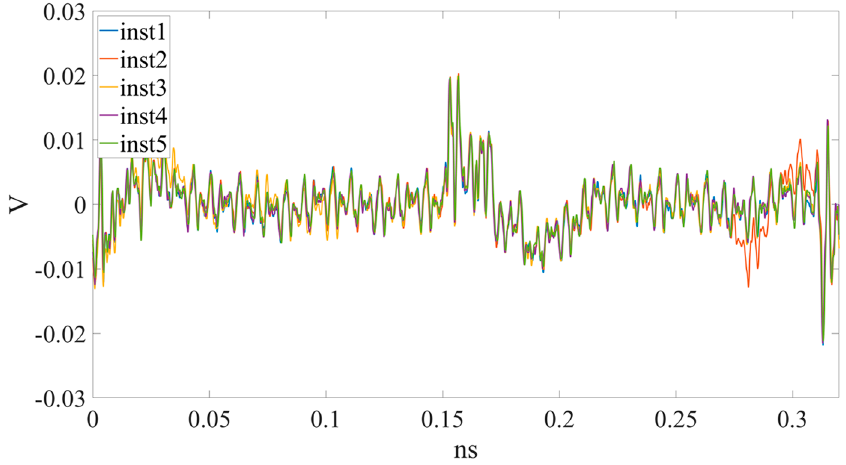
Figure 1. Different EM-leak signals of the FPGA-MCU-IP DUT corresponding to different instructions measured by the proposed platform.